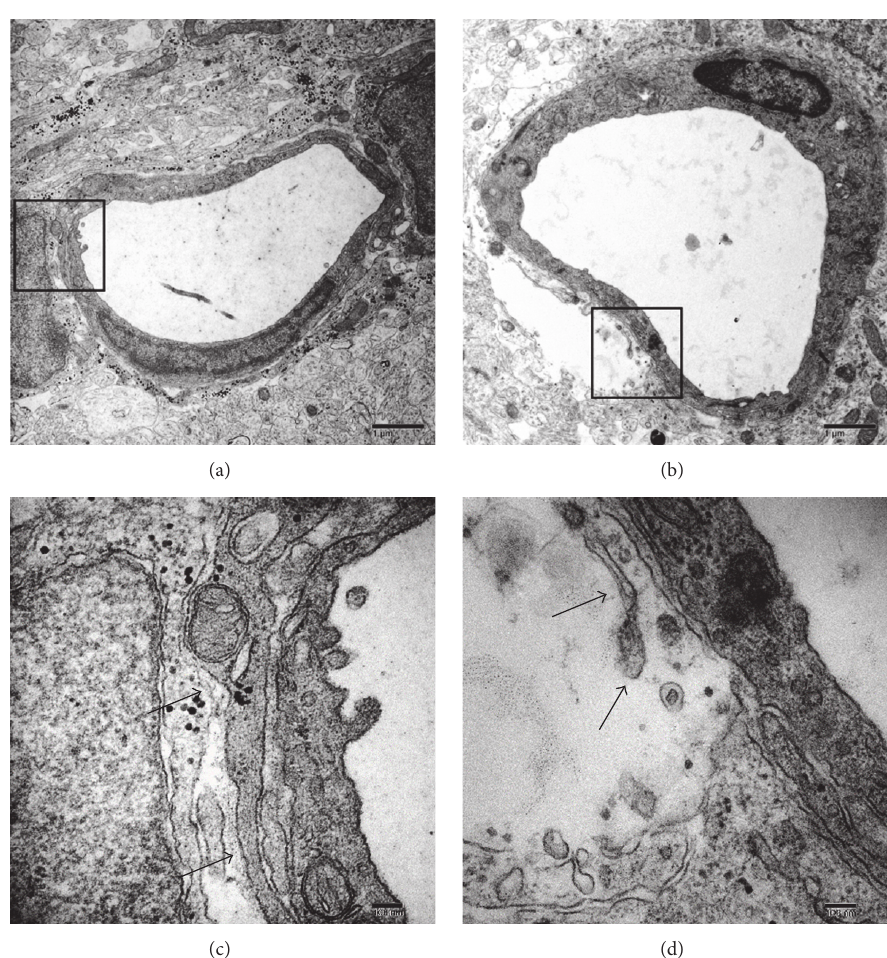
Figure 1: Ultrastructure of the capillaries in the hippocampus CA1 region in neonatal mice of the (a, c) control and (b, d) sevoflurane exposure groups. In the control group (a, c), the capillaries were continuous and integrated (black arrows), and the perivascular spaces were normal. In comparison, the ultrastructural integrity of the BBB appeared to be disrupted (black arrows) as a result of enlarged perivascular spaces after 6 h of sevoflurane exposure (b, d). Higher magnification views of the contacts (black boxes in (a) and (b)) are presented in (c) and (d). Scale bars: 1 𝜇 m (a, b); 100nm (c,